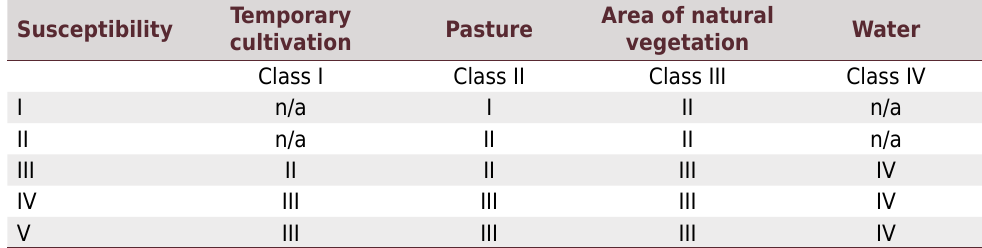
Table 6. Classes of potential for linear erosion in the municipality of São Miguel do Araguaia, state of Goiás, Brazil Susceptibility